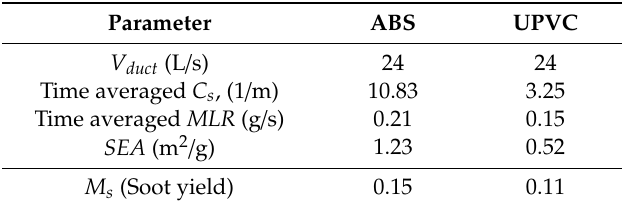
Table 2. Summary of soot yield for ABS and UPVC smoke particles.